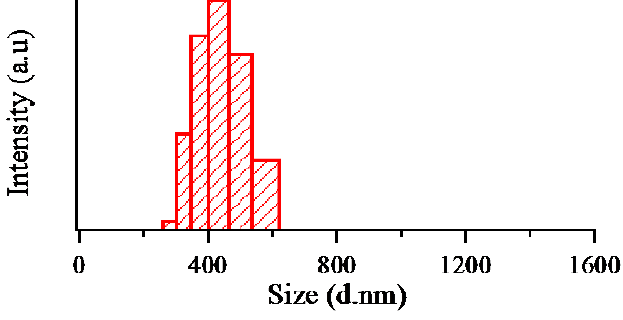
Figure 8. Size distribution of the dispersed multilayer graphene.